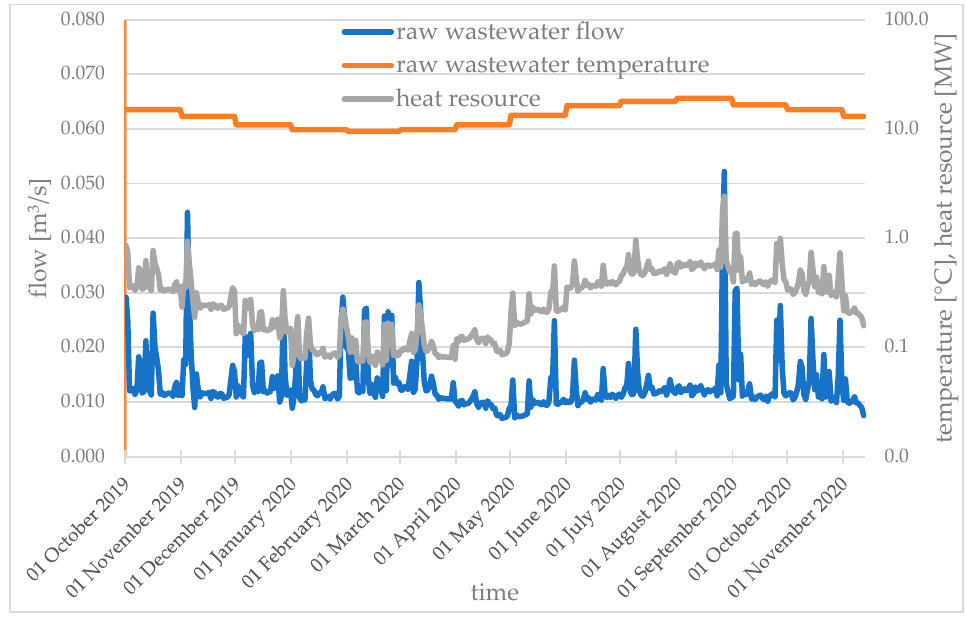
Figure 5. Heat recovery potential of raw wastewater.